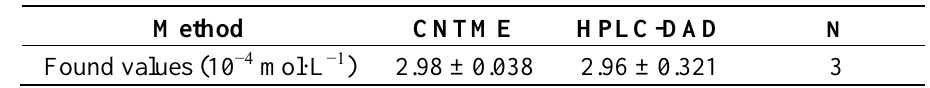
Table 1. Determination of AG25 in a sample collected at a water treatment station using the proposed method and the HPLC-DAD